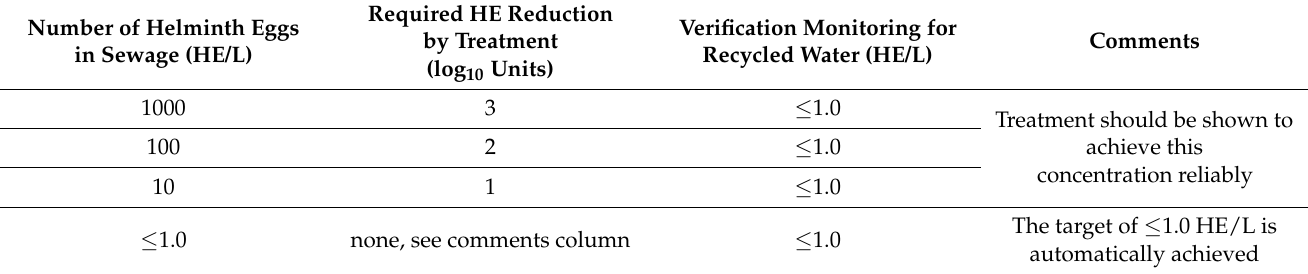
Table 3. Options for the reduction of helminth eggs in sewage and verification concentrations. Number of Helminth Eggs in Sewage